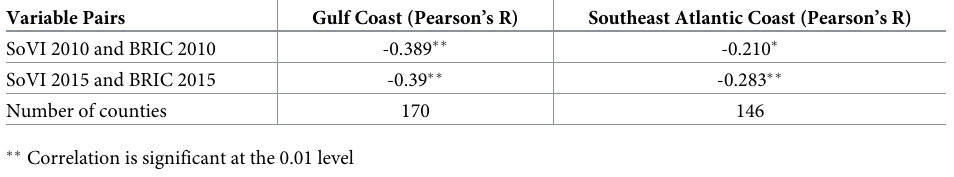
Table 2. Pearson correlation test results between SoVI, BRIC, and BRIC components (Gulf coast and southeast Atlantic coast regions).